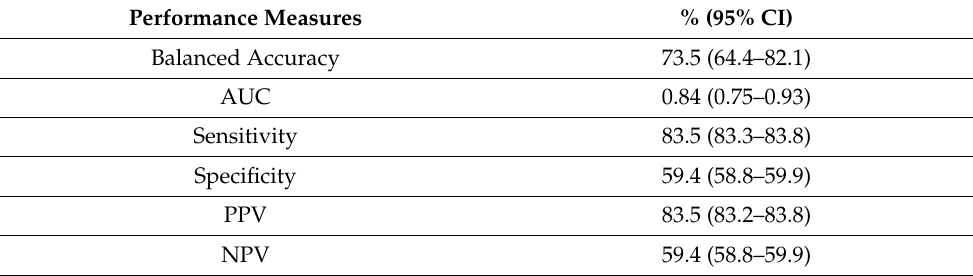
Table 4. Final SVM model performance measures on validation